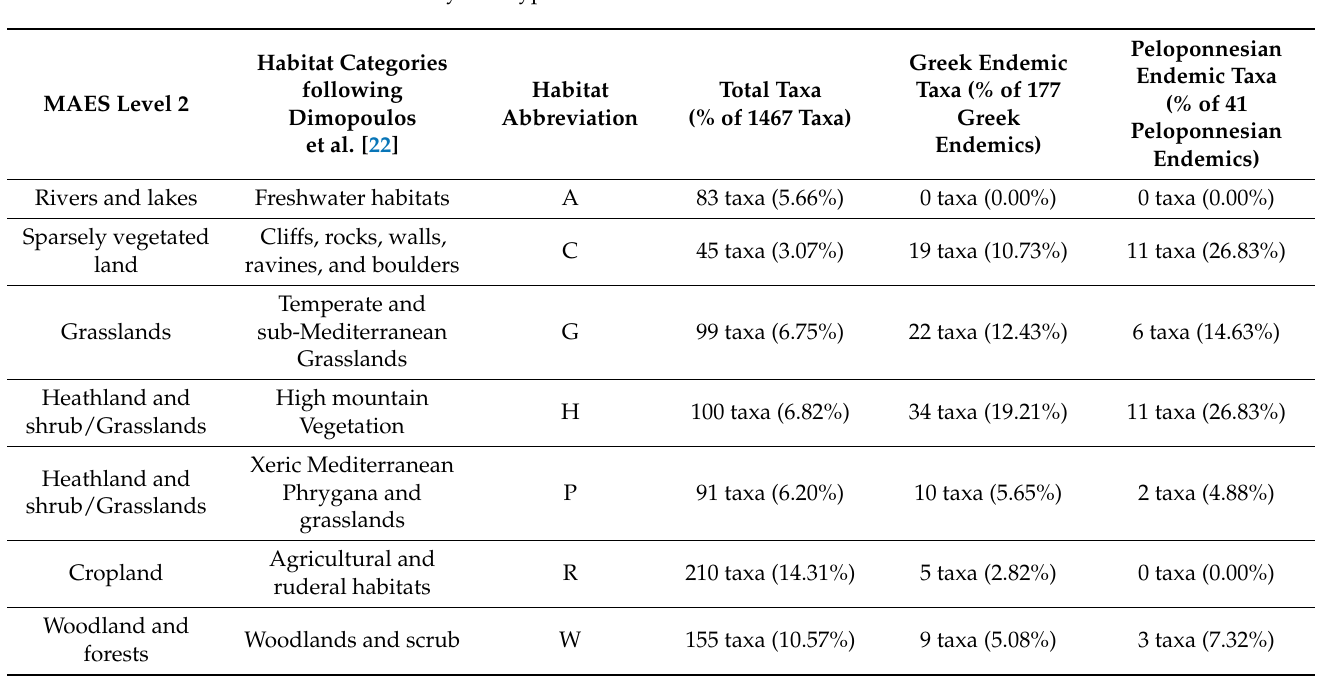
Table 3. Distribution of CVNP’s total Greek endemic and Peloponnesian endemic plant taxa exclu- sively present at each habitat category [22]. Left column includes the correspondence to the MAES level 2 ecosystem